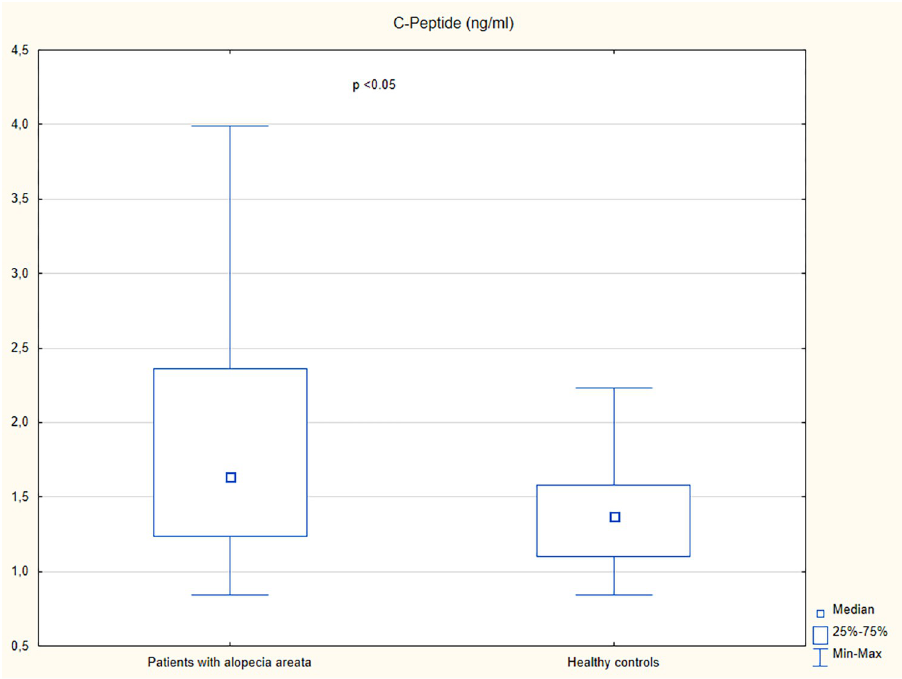
Fig 3. Serum concentrations of c-peptide in patients with alopecia areata and healthy